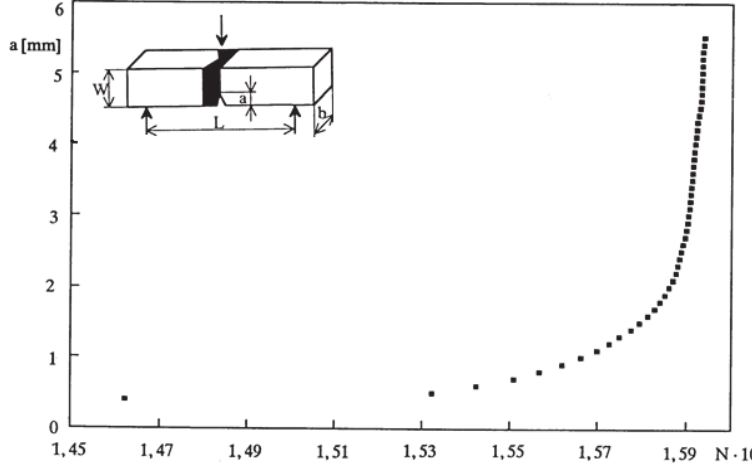
Figure 10: Experimentally obtained a-N